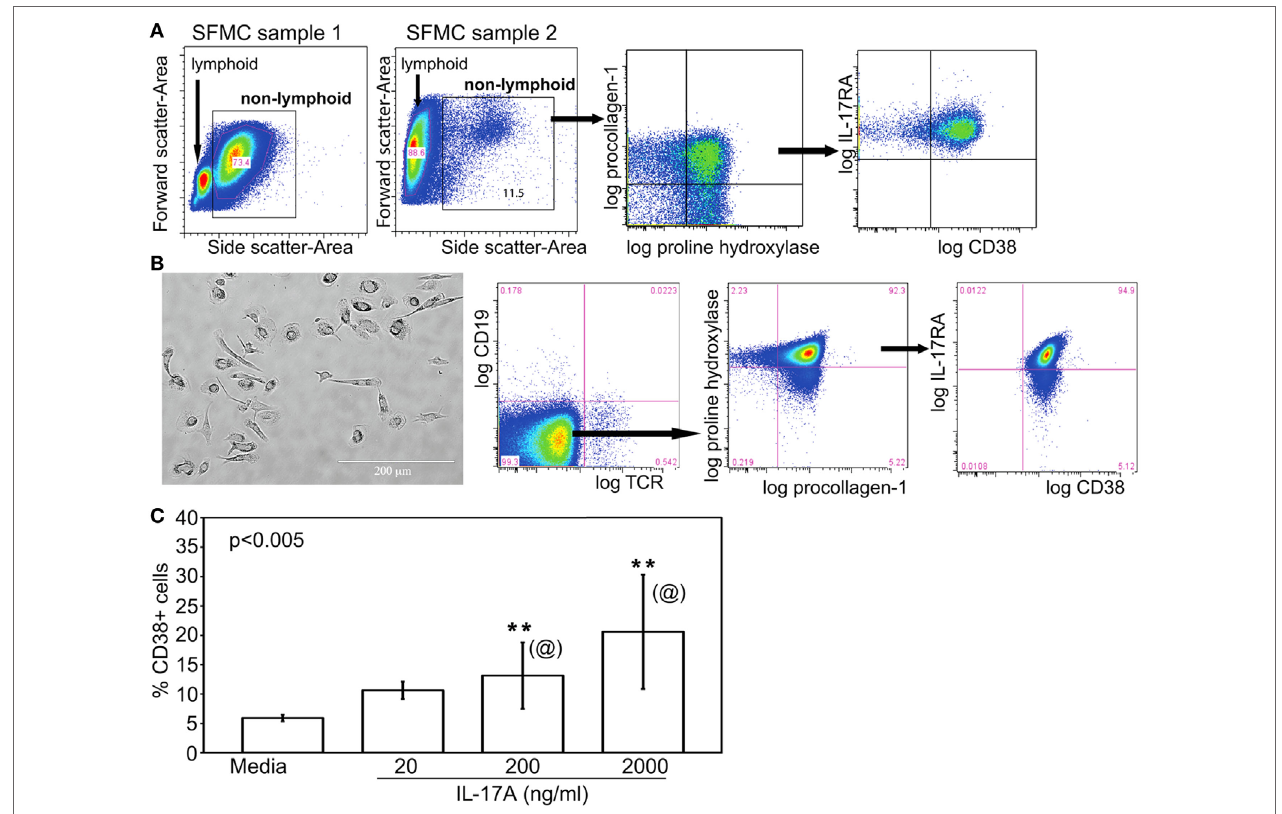
FigUre 7 | Fibrocyte-like cells are non-lymphoid IL-17A-responsive components of SF. (a) The general electronic gating strategy to set a live single cell gate was done as in Figure 2a . The cytograms shown illustrate the gated larger sized cells in SFMC, i.e., boxed higher forward versus side scatter. As depicted, the proportions of these non-lymphoid SFMC varied widely among patients. These cells co-expressed procollagen 1 and proline hydroxylase, known markers of fibroblasts and mesenchymal fibrocytes. These cells, referred to as FLC, also expressed IL-17RA and CD38. (B) Representative micrograph of 10–15 day cultured, plate-adherent FLC showing stellate to ameboid morphology. Their typical cytogram profile showed negative staining for T and B cell markers, but positive staining of proline hydroxylase, procollagen 1, IL-17RA, and CD38. (c) CD38 expression on FLC (bar means, SD whiskers; n = 5 per group) incubated with three doses of recombinant IL-17A for 24 h. The indicated P -value was determined by Kruskal–Wallis ANOVA. Post hoc group comparisons by Tukey: [@] indicate no significant differences between 200 and 2,000 ng/ml doses of IL-17A; [**] indicates responses to 200 or 2,000 ng/ml was significantly different ( P < 0.05) than those seen with 20 ng/ml IL-17A or media